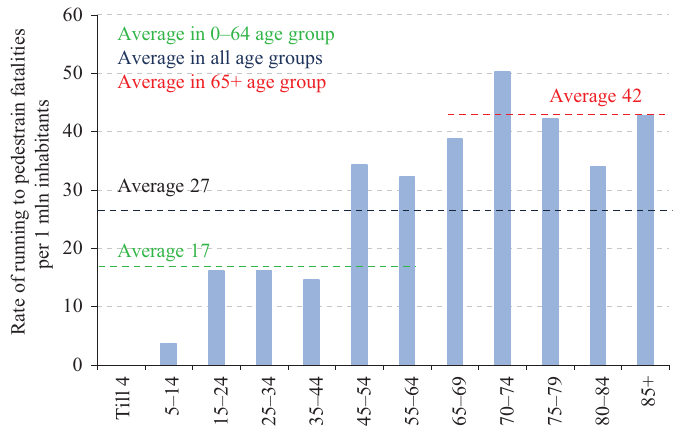
Figure 7. The rate of running to pedestrian fatalities per 1 million inhabitants per age group in Lithuania in